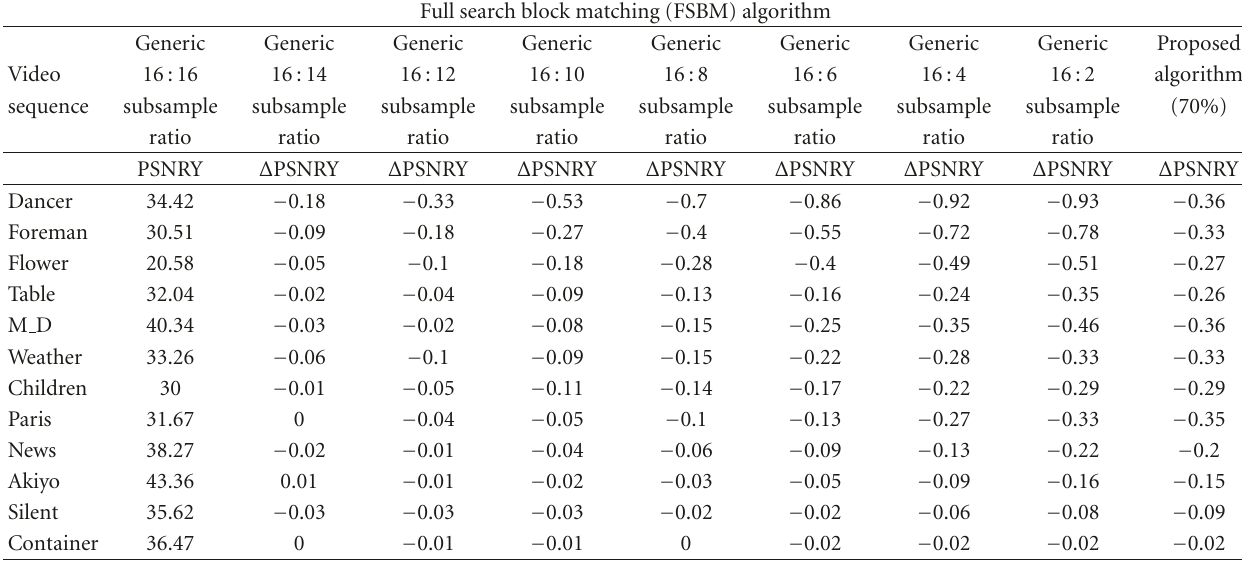
Table 5: Performance analysis of quality degradation for various video sequences using various methods. (Note that the proposed algorithm can always keep the quality degradation